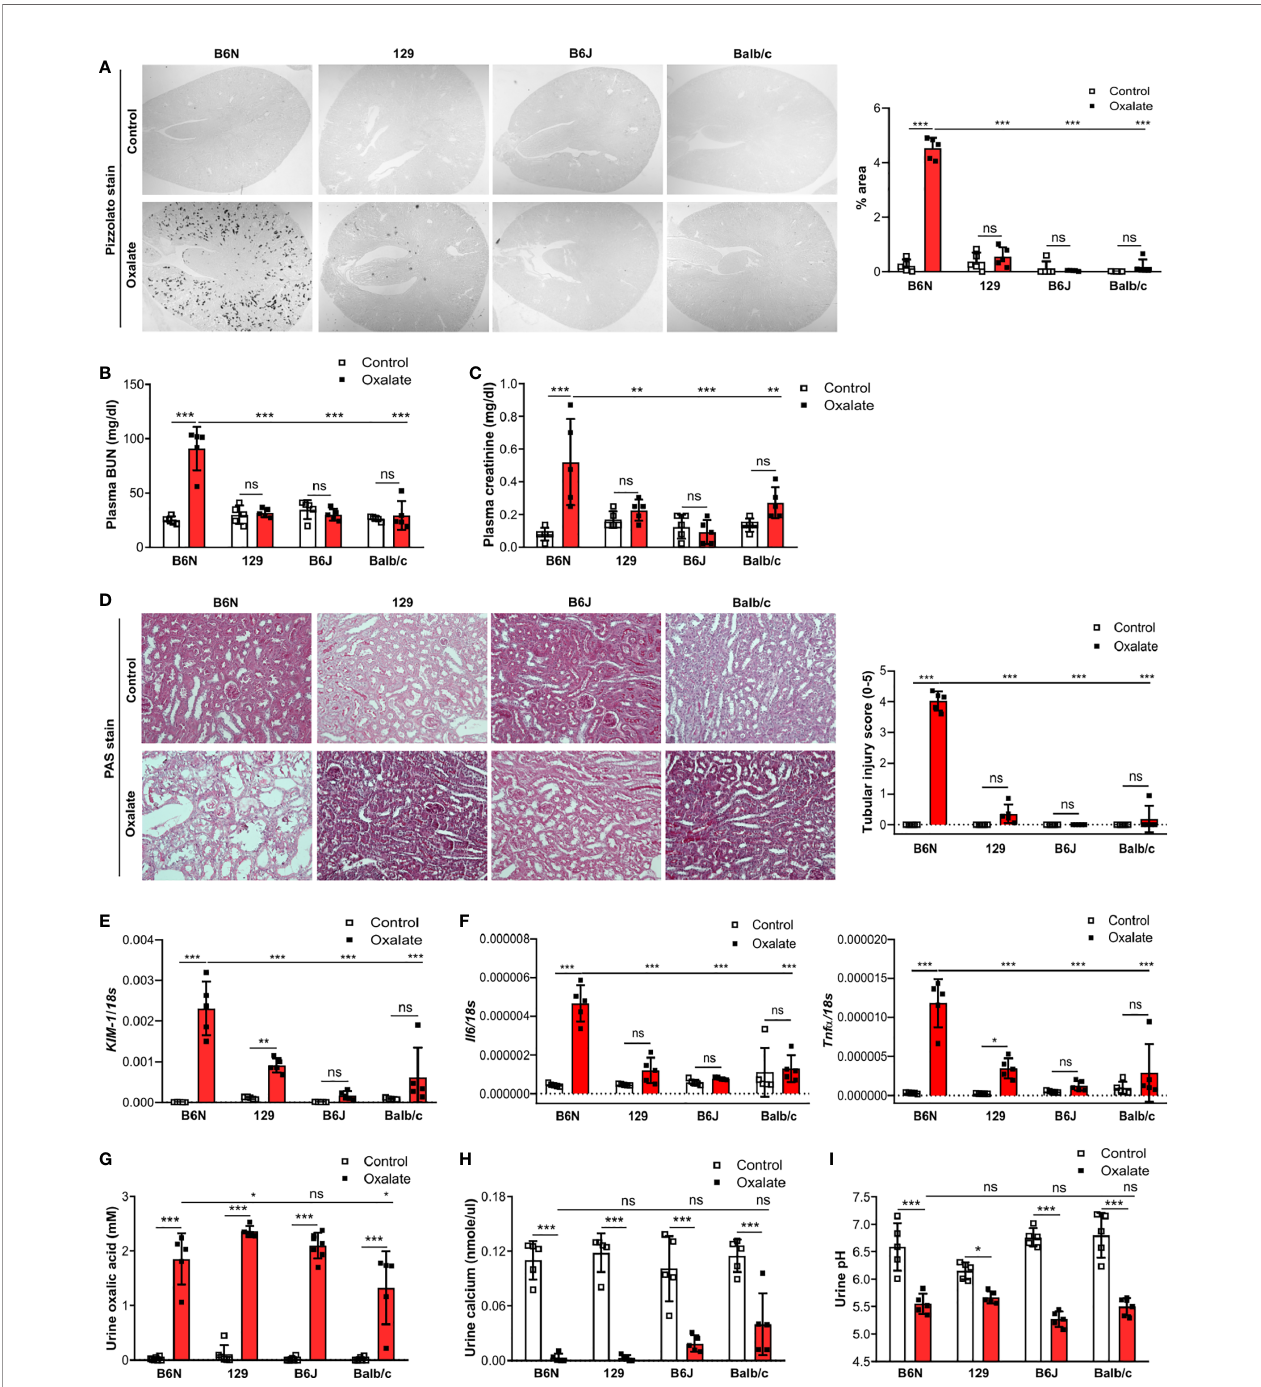
FIGURE 2 | B6N but not B6J, 129 and Balb/c mice develop CaOx-related nephrocalcinosis. B6N, 129, B6J and Balb/c mice were either placed on a control diet or an oxalate-rich diet for 14 days. (A) Pizzolato staining to identify CaOx crystals and quanti fi cation (% area) of kidney sections. Original magni fi cation ×25. (B, C) Plasma BUN (B) and plasma creatinine (C) levels were measured using colorimetric assays. (D) Images of PAS stained kidney sections and quanti fi cation of tubular injury score. Original magni fi cation x200. (E, F) Gene expression of KIM-1 (E) as well as Il6 and Tnf a (F) in kidney tissue determined by RT-PCR. (G – I) Urine was collected and the concentrations of oxalic acid (G) and calcium (H) as well as the urine pH (I) determined. Data are mean ± SD from 5 mice per group. *p < 0.05; **p < 0.01; ***p < 0.001; ns, not signi fi